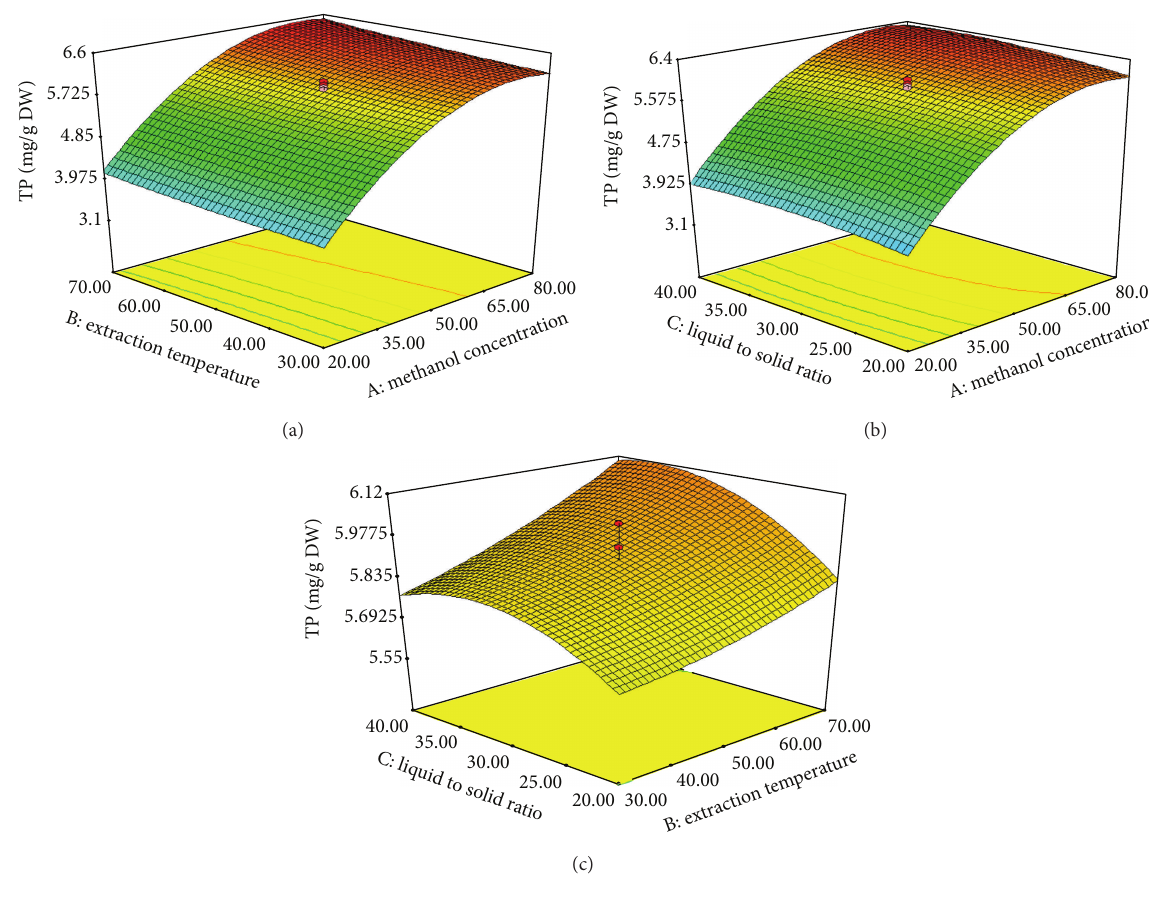
Figure 2: Response surface plots for the effects of MC (20–80%), ET (30–70 ∘ C), and LS ratio (20–40 mL/g) on the TP content of Pandan extract. MC and ET (a), MC and LS ratio (b), and ET and LS ratio